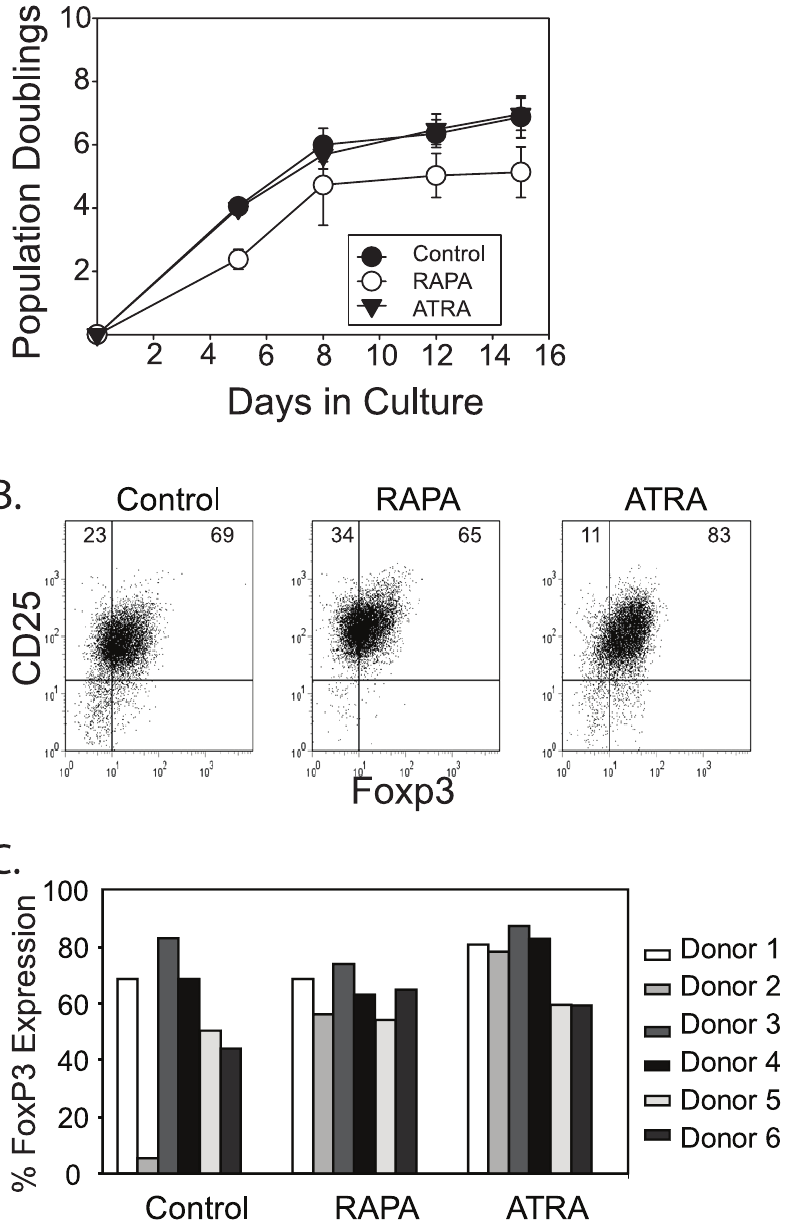
Figure 1. ATRA does not impair human T cell proliferation and augments FOXP3 expression during exvivo expansion. A . 200,000 sorted primary human Tregs were stimulated with anti-CD3 Ab loaded K.64.86 cells and cultured in the presence of 10% human serum alone for 15 days (control) or in serum-containing medium with the addition of 100 ng/ml of rapamycin (RAPA) or 10 m M ATRA. Cell counts were performed on Days 5, 8, 12 and 15 and data reflect the average of 3 independent experiments. The error bars reflect standard deviation. B . After 15 days of culture, each cell population from a single donor described in Panel A was analyzed for CD25 and FOXP3 expression by flow cytometry. C . Composite FOXP3 expression data from 6 independent experiments performed using 6 unique donors. The donor shown in Panel B is donor # 4.